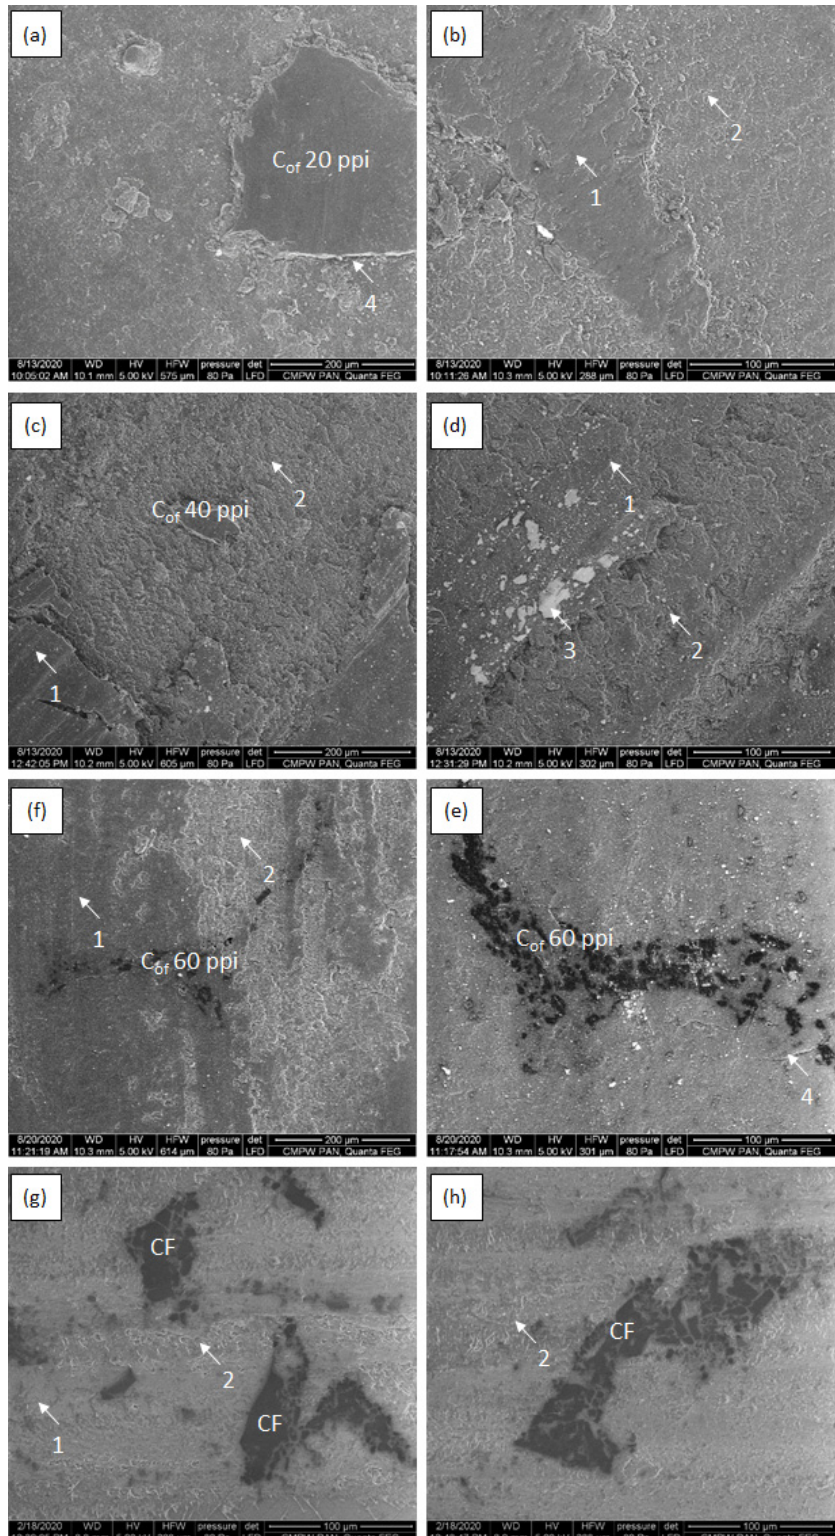
Figure 8. SEM micrographs of epoxy—C of 20 ppi ( a , b ), epoxy—C of 40 ppi ( c , d ),epoxy—C of 20 ppi ( e , f ) and epoxy–CF ( g , h ) after cooperation with cast iron counter sample under 0.7 MPa load; 1—abrasive wear of carbon foam, 2—abrasive wear and adhesive shear and transfer of matrix, 3—solid tribofilm.